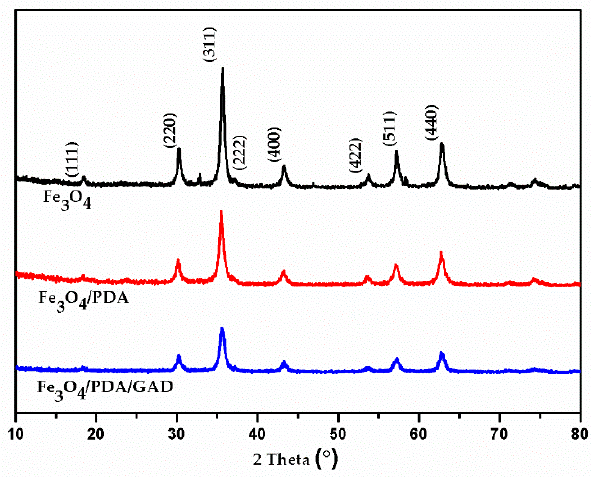
Figure 1. XRD pattern of Fe 3 O 4 , Fe 3 O 4 /PDA, and Fe 3 O 4 /PDA/GAD.